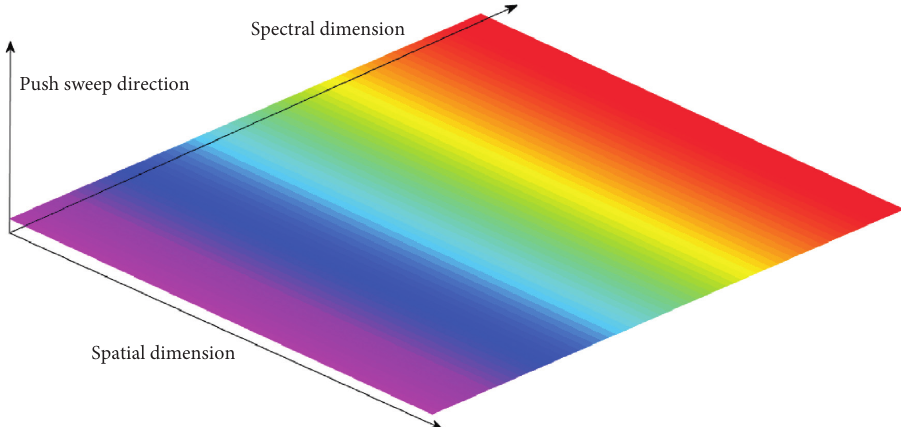
Figure 3: Push-sweep imaging schematic.